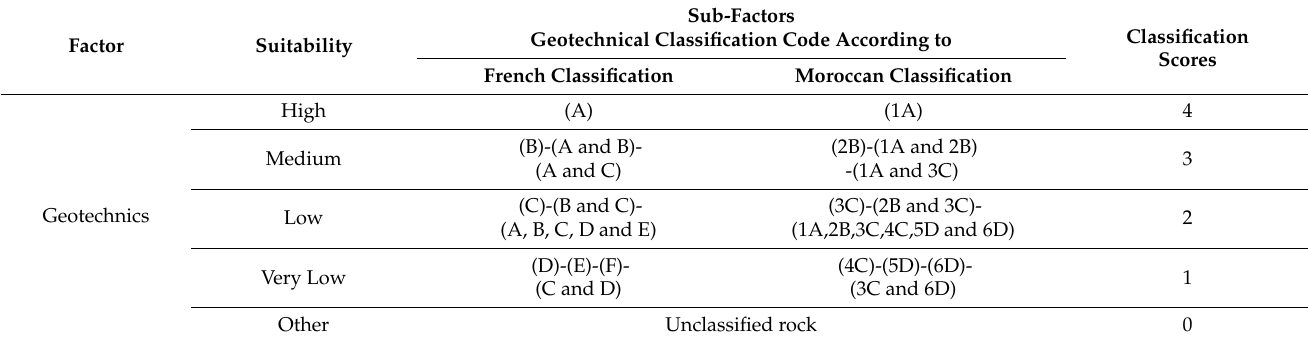
Table 3. Classification scores of each sub-factor were used to select potential rock